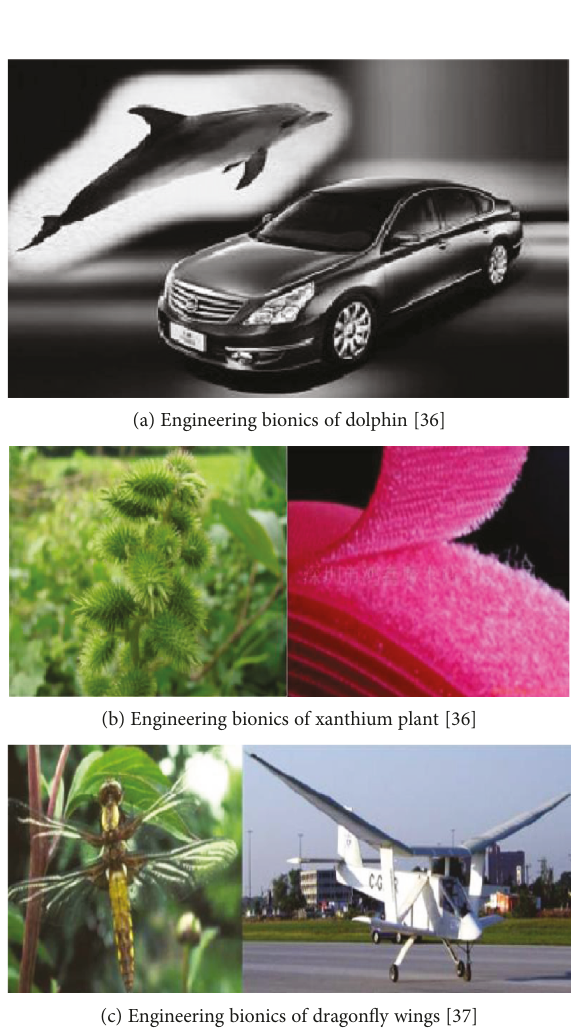
Figure 1: Real examples of engineering bionic design.